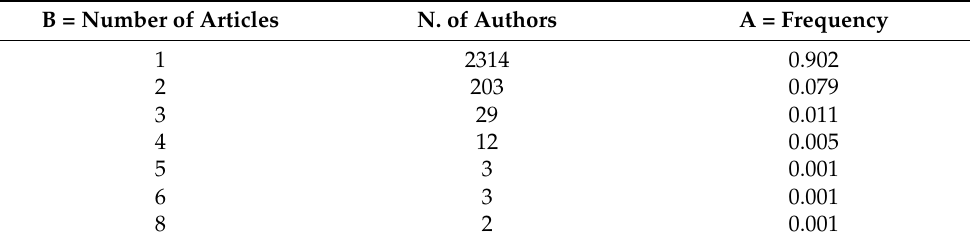
Table 2. The number of articles published by the number of corresponding authors. B = Number of